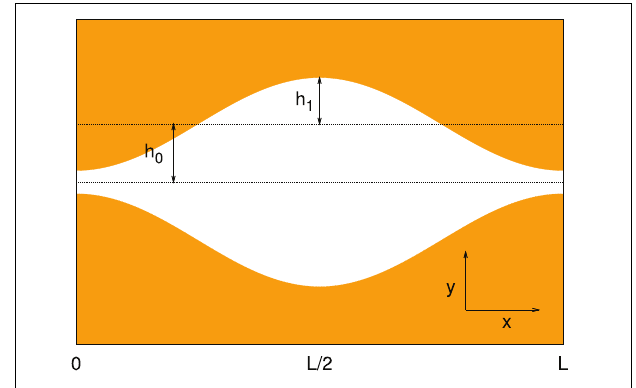
FIGURE 2 | Schematic view of a channel characterized by an average width h 0 , modulation h 1 and period L . The channel width is assumed constant along the z direction assumed to point out of the